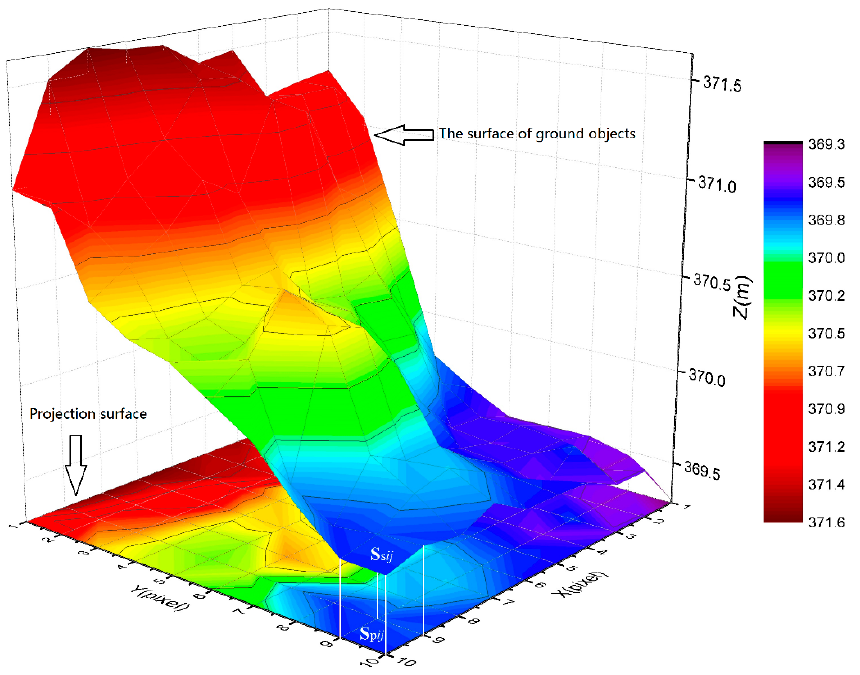
Figure 4. A three-dimensional display of the ground objects surface area of a grid unit and its projected area on the horizontal plane.